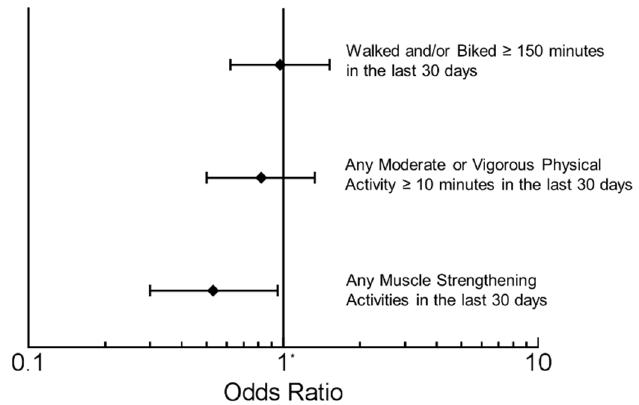
Figure Figure 3. Self ‐ reported physical activities of adults taking proton pump inhibitors (PPIs) in the 2005–